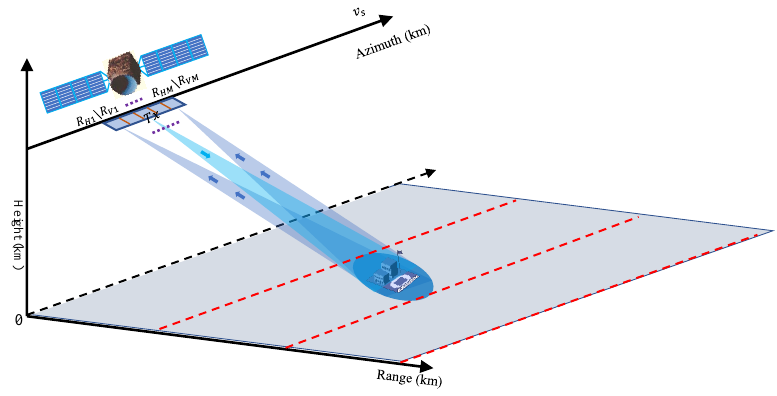
Figure 1. Geometry of the multichannel quad-pol SAR